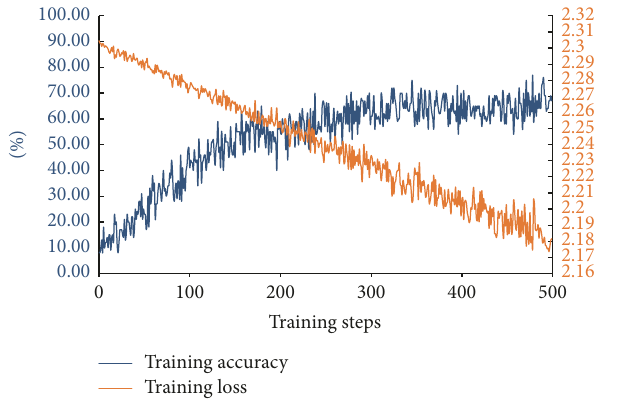
Figure 9: Training accuracy and loss for 2nd training.